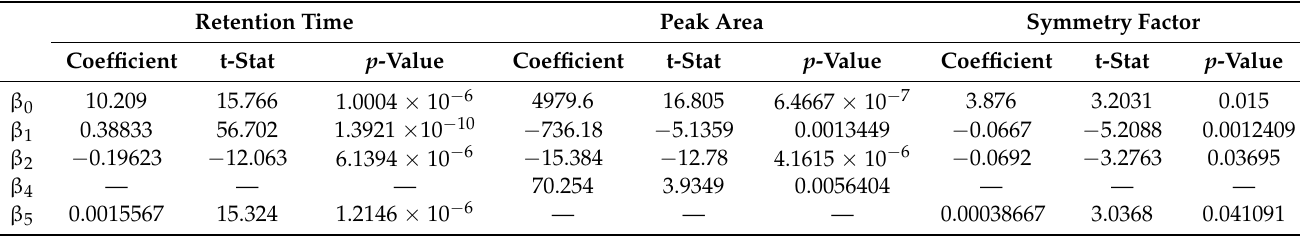
Table 3. Statistical calculation of a second-order polynomial exploring quadratic response surfaces